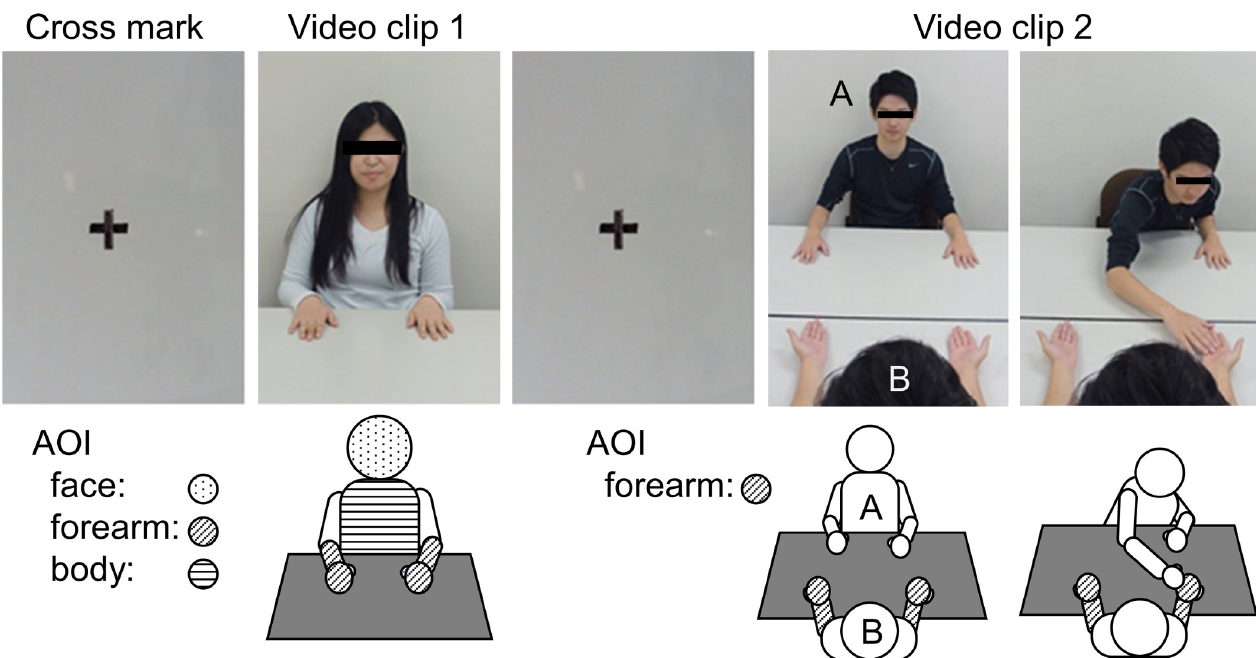
Fig 1. Video clips 1 and 2. In video clip 1, a video (without audio) of a young person talking was presented for 7 sec. A total of nine videos of the young person (5 men and 4 women) were presented, and the cross-mark was presented for 3 sec. during each video. In video clip 2, a video (without audio) of Person A touching the hand of Person B was presented for 7 sec. The role of Person A was performed by one man and one woman. A video of Person A touching the right and left hand of Person B was presented 4 times (two times each for man and woman). In addition, cross-marks were presented for 3 sec. during each video. The illustration below shows the AOI for each video clip. AOI: areas of Interest.